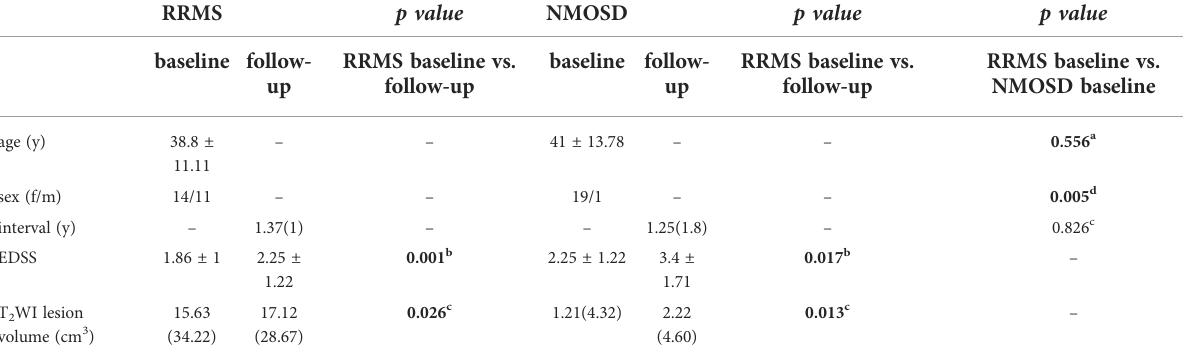
TABLE 2 Demographic and clinical variables at longitudinal